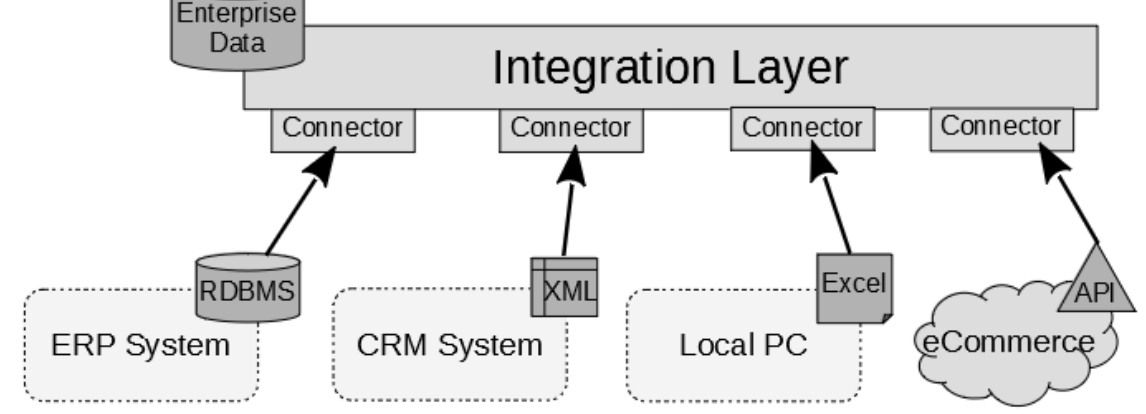
Figure 2. Data integration layer: basic architecture.